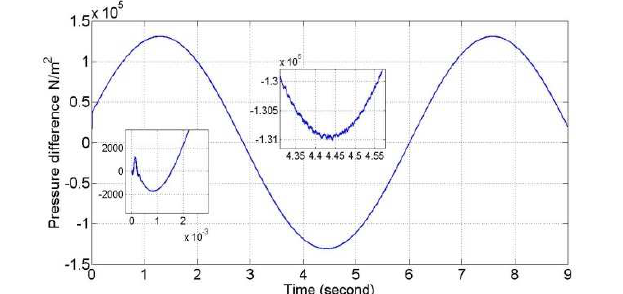
Fig. 19. Pressure difference under